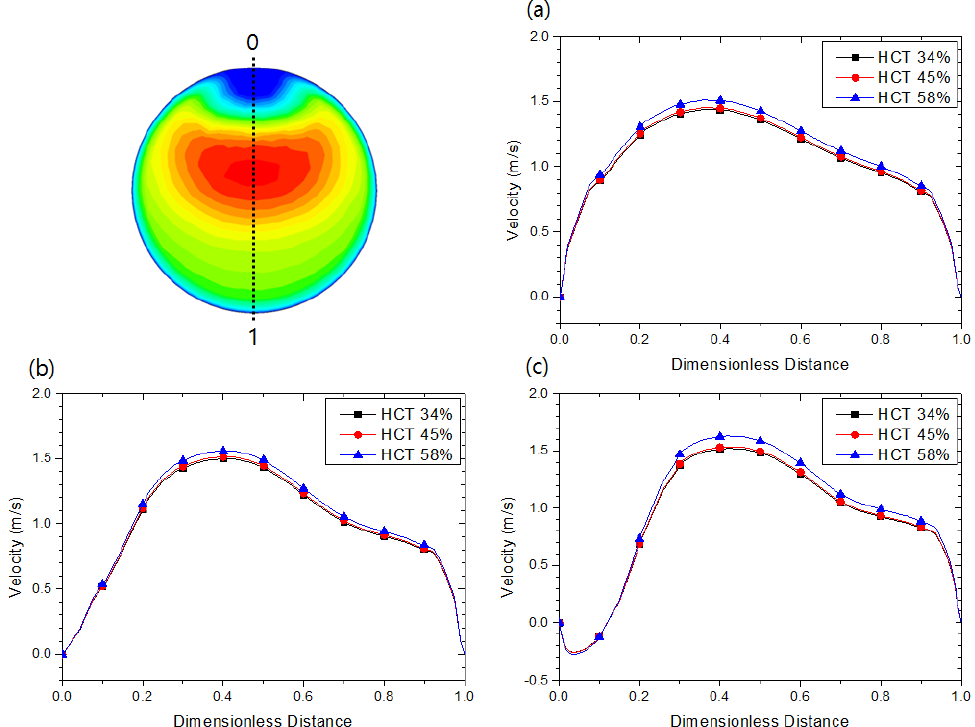
Figure 9. Velocity, w, distribution according to the hematocrit at Line (E), anastomosis angle of ( a ), ( b ), and ( c ) are 15°, 30°, and 45°, respectively.